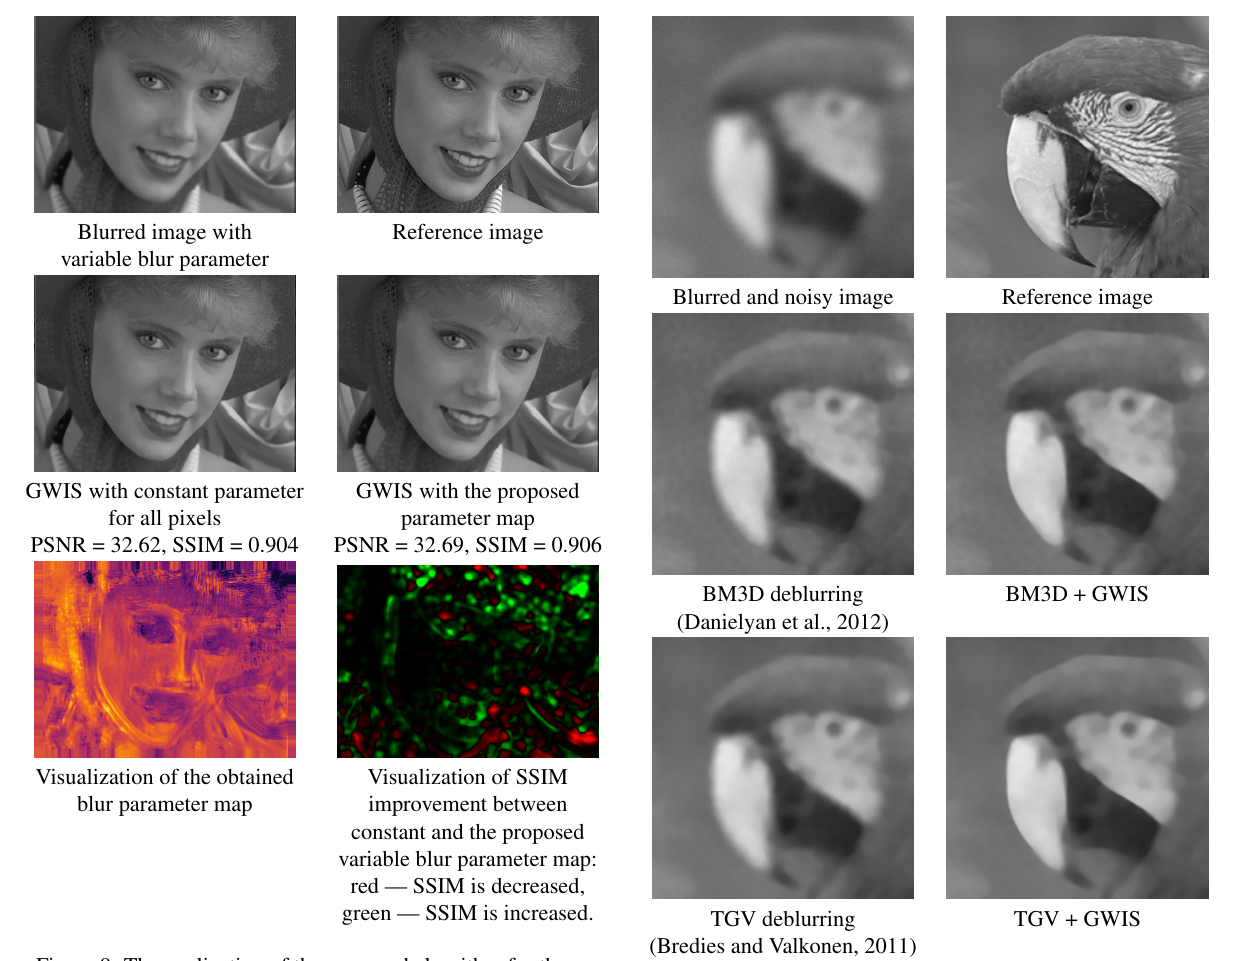
Figure 9. The application of the proposed algorithm for the image with non-uniform blur. Figure 10. The results of post-processing by GWIS algorithm after deblurring with the proposed blur parameter